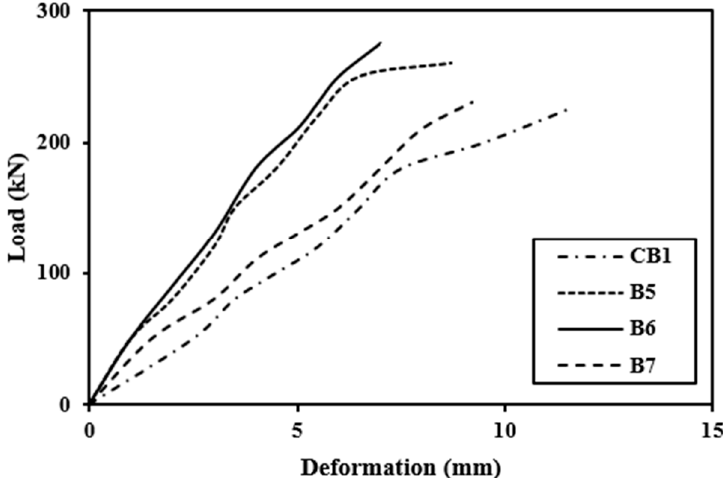
Figure 17. Load deflection behavior of strengthened and control beam.